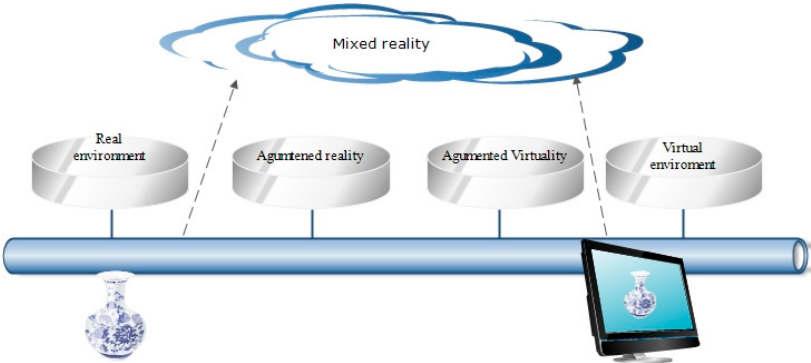
Figure 2. Reality–Virtuality continuum (Adopted from [18]).